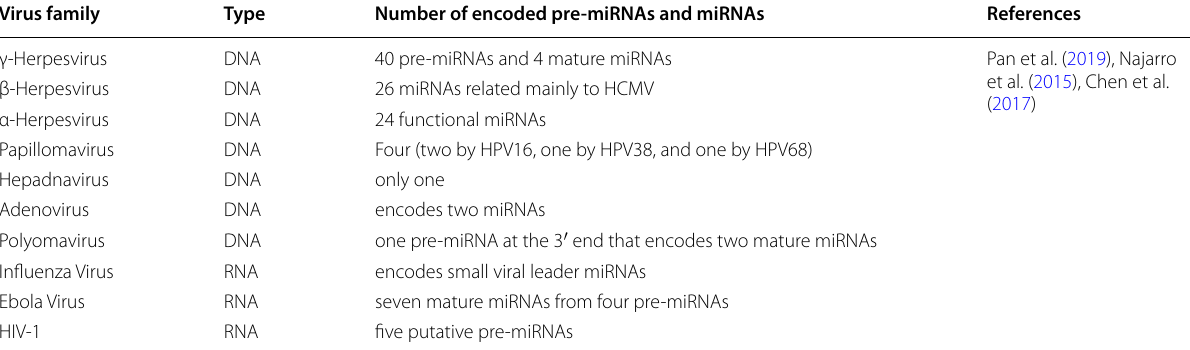
Table 2 DNA and RNA viruses producing miRNAs and the numbers of miRNAs discovered for each Virus family DNA Deoxy-Ribonucleic acid, HCMV Human Cytomegalovirus, HIV Human immunodeficiency virus, HPV Human Papilloma Virus, miRNA Micro Ribonucleic acid